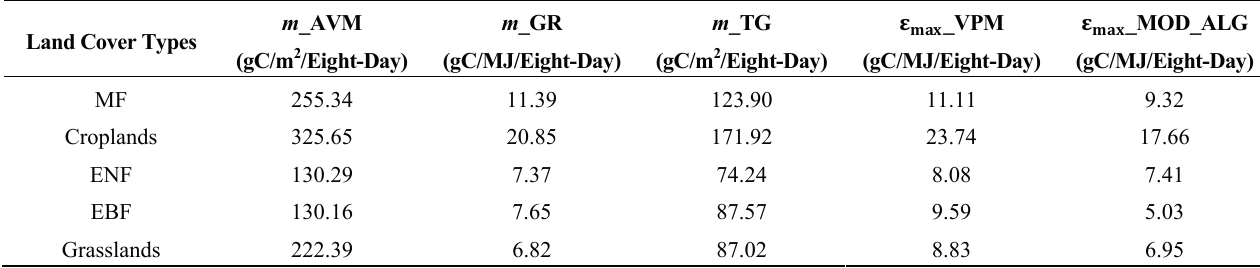
_VPM and (cid:2013) _MOD_ALG) (cid:3040)(cid:3028)(cid:3051) (cid:3040)(cid:3028)(cid:3051)